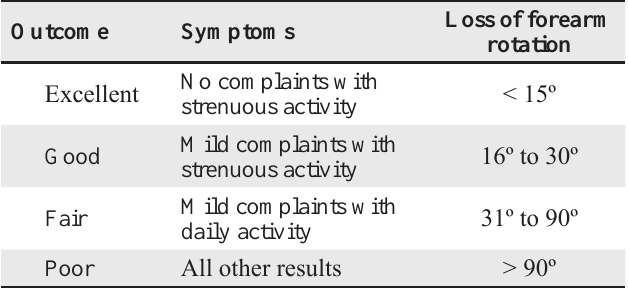
Table 1 : Grading system of price et al.